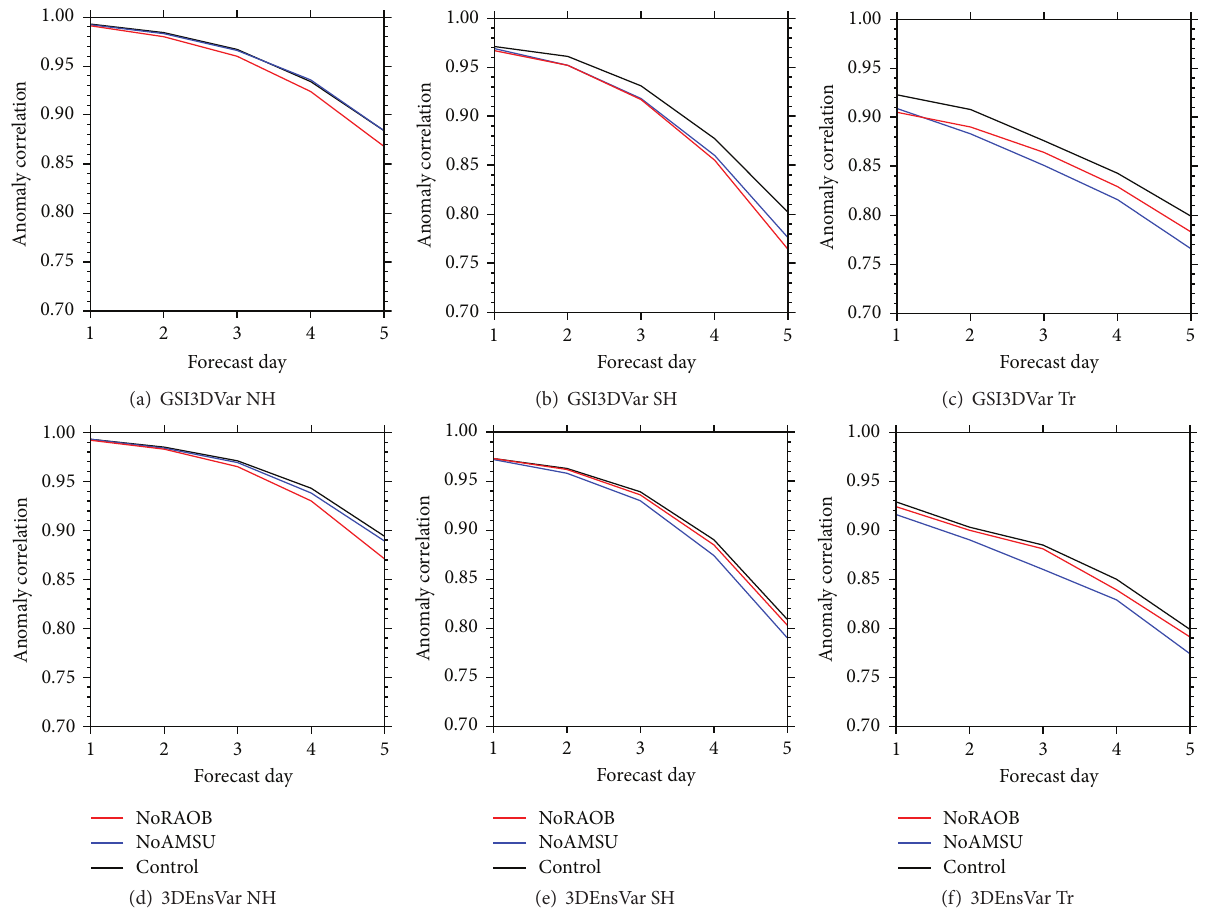
Figure 10: Anomaly correlation for geopotential height averaged vertically for the GSI3DVar (top panel) and the 3DEnsVar (bottom panel) as a function of forecast days for Northern Hemisphere (a, d), Southern Hemisphere (b, e), and tropics (c, f). Black, blue, and red colors are for control, NoAMSU, and NoRAOB experiments in the GSI3DVar and the